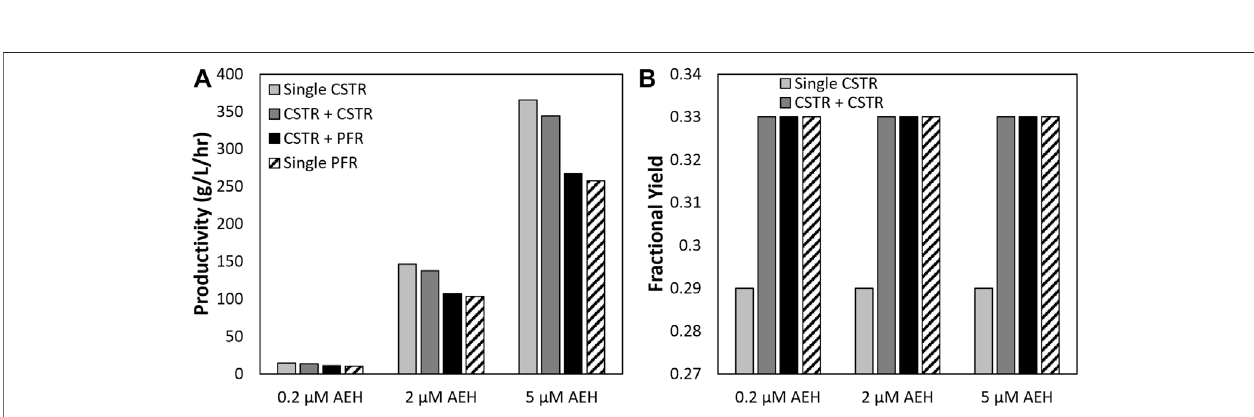
Frontiers in Bioengineering and Biotechnology |